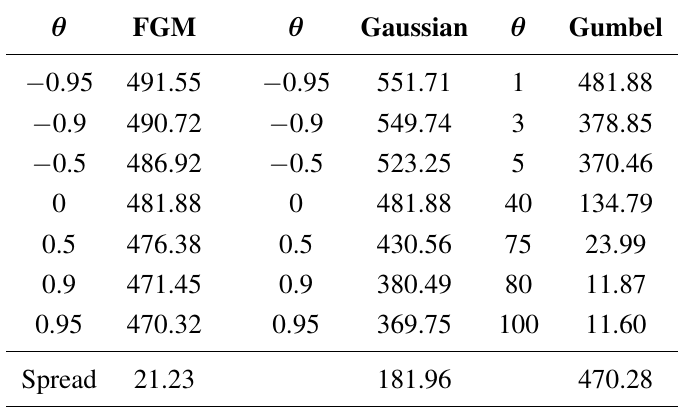
Table 6. Loaded premium according to the SD principle under various